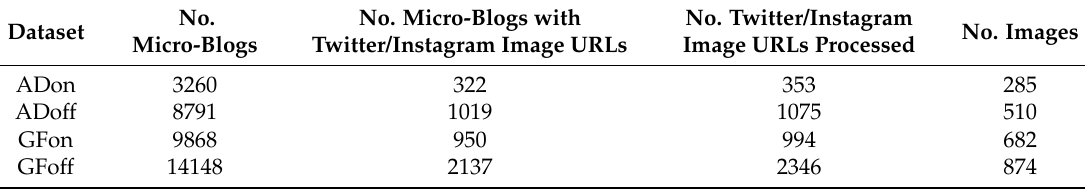
Table 3. The number of linked images contained in each dataset resulting from pre-processing to eliminate content that cannot support inferences of Witnessing OTG, such as non-original content.